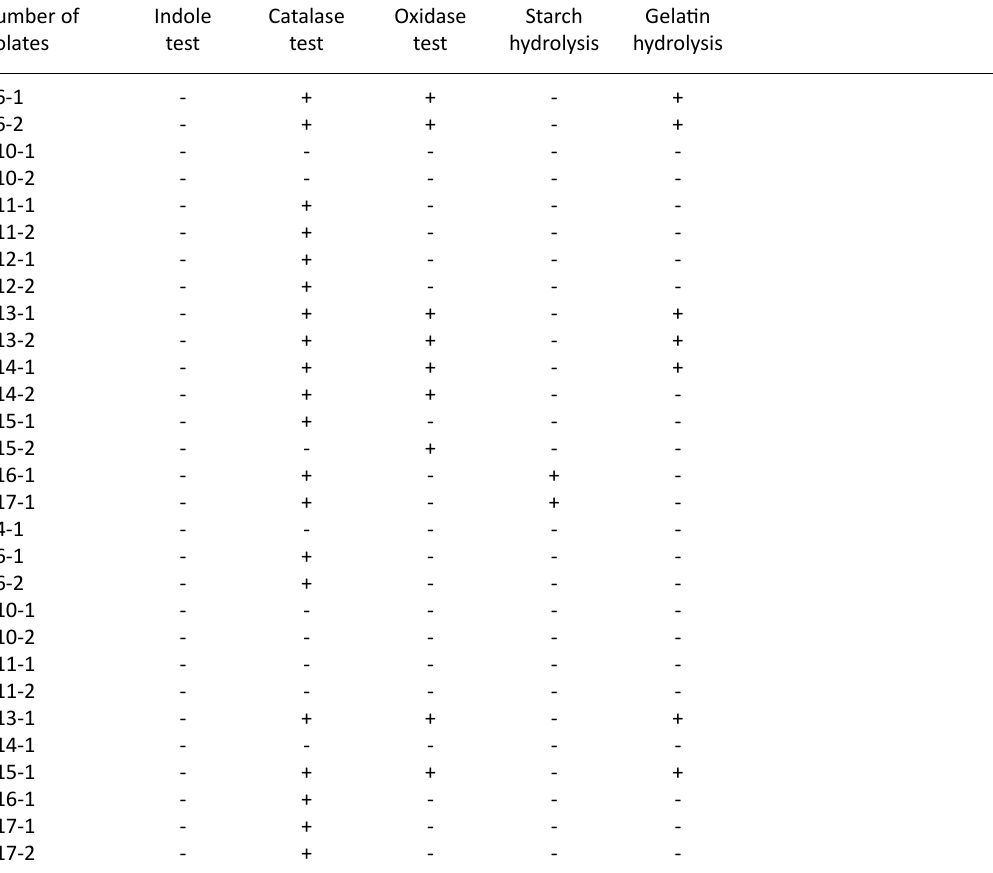
table 5. Biochemical test of bacterial isolates from Domiaty and Hungarian cheese